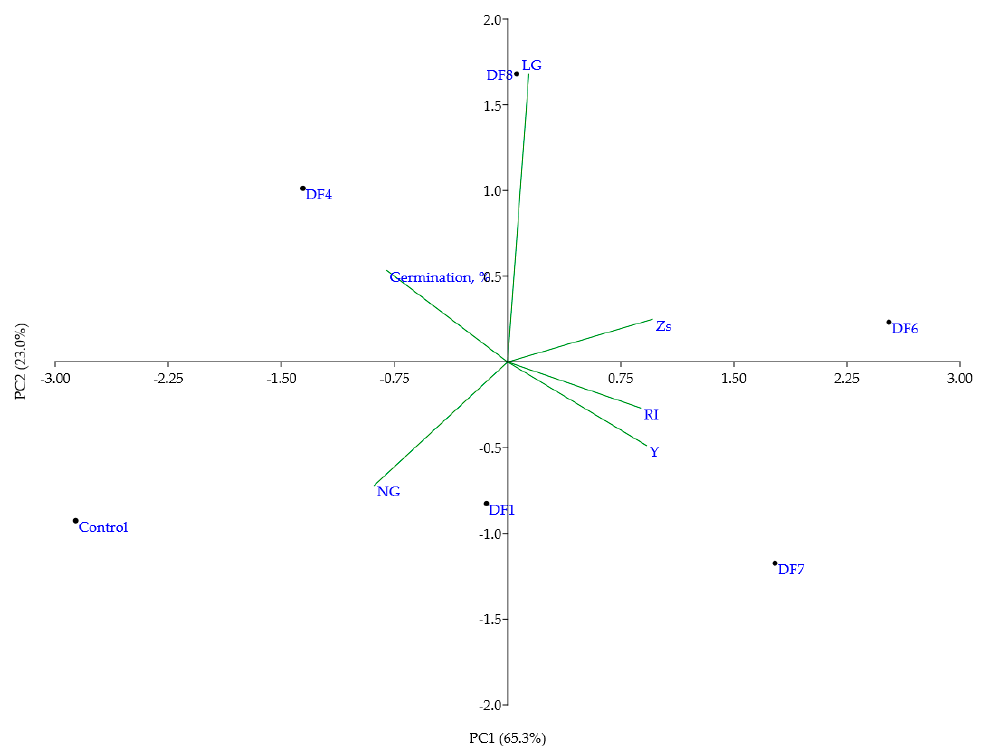
Figure 3. Biplot of the first two principal components (PCs) (accounting for 88.3% of the variance) obtained by including two chemical analysis-based soil indices (Zs and RI), germination rate, and frequencies of Co-induced morphoses in V. faba plants grown in soils with different industrial pollution levels. Phenotypes of morphoses: NG—normal green, LG—light green, Y—yellow; C— plants grown in control soil; DF1,4,6,7,8—plants grown in soil collected from different sites of the drill factory.